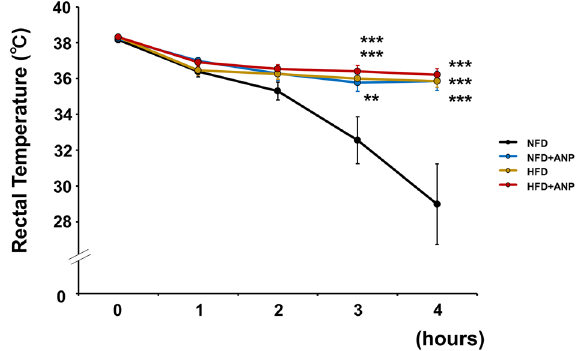
Figure 5. Changes in rectal temperature during acute cold exposure. Rectal temperature profiles during cold exposure at 4 °C for 4 h in the indicated mice at 3 weeks after treatment with or without ANP (n = 10 each). Data are mean ± SEM. ** P < 0.01 and *** P < 0.001 versus NFD at each time